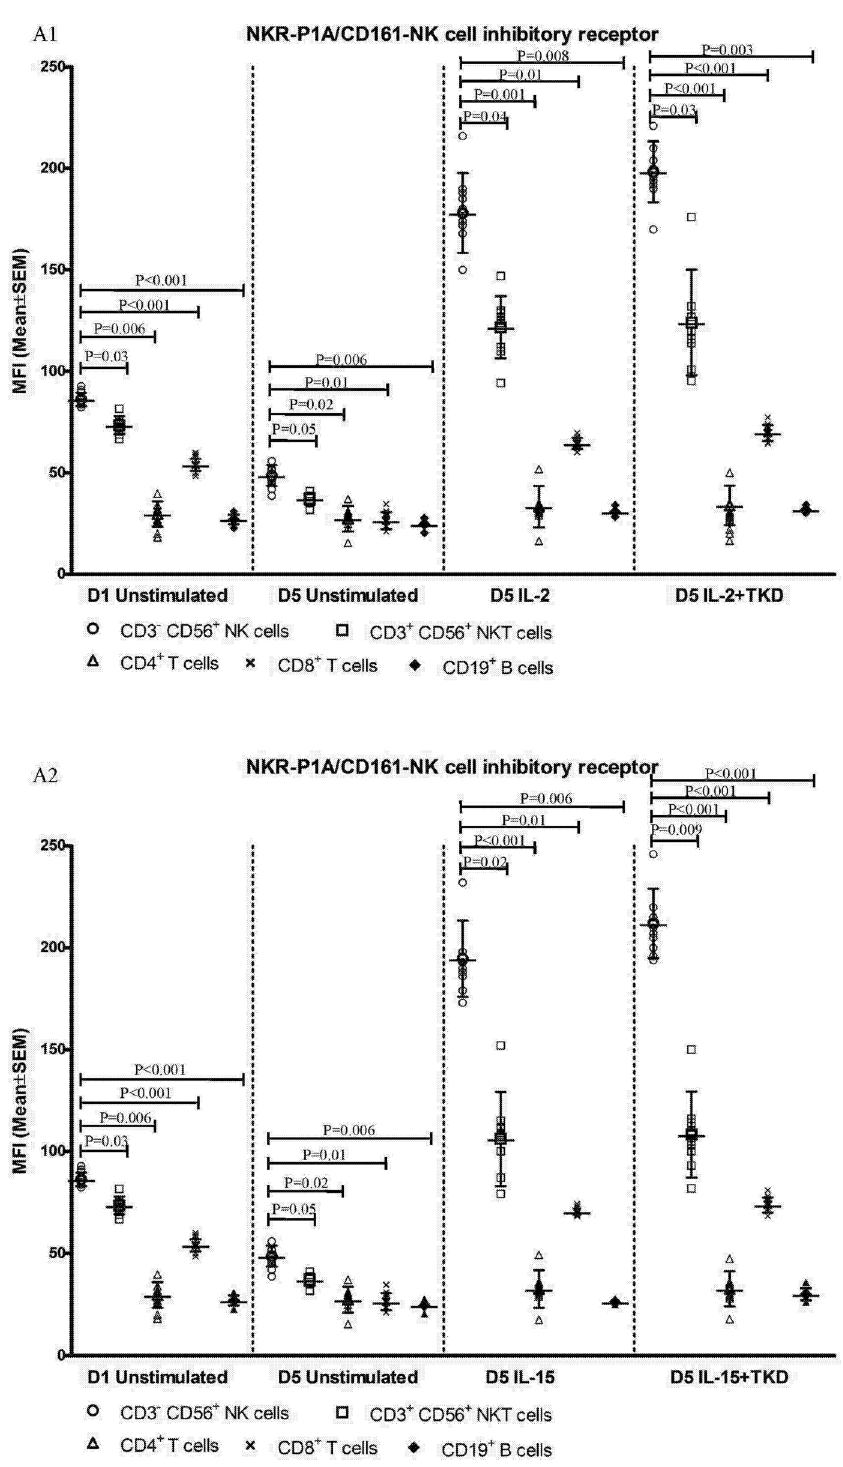
Fig 13. The effect of IL-2, IL-15, IL-2/TKD and IL-15/TKD on the expression of NKR-P1A in peripheral blood mononuclear cells of healthy individuals — the amount of receptor expressed by CD3 - CD56 + NK cells, CD3 + CD56 + NKT cells, CD4 + T cells, CD8 + T cells and CD19 + B cells (the median fluorescence intensity). The amount of NKR-P1A expressed by CD3 - CD56 + NK cells, CD3 + CD56 + NKT cells, CD4 + T cells, CD8 + T cells and CD19 + B cells was examined within the fraction of unstimulated and